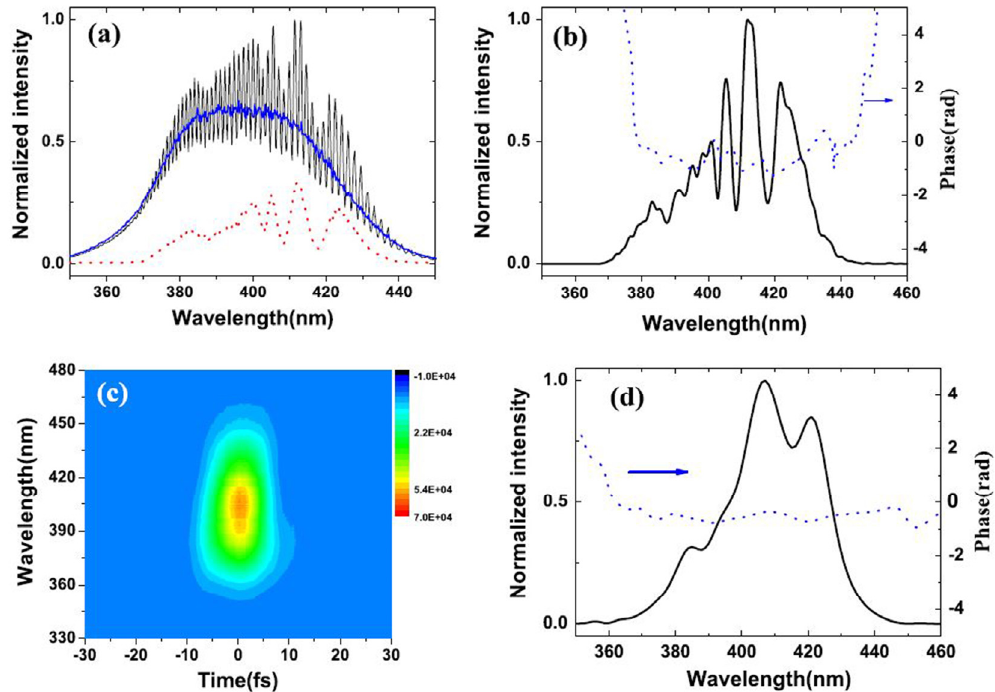
Figure 10. ( a ) Spectra of the compressed pulse at 400 nm (red dotted line), the SD1 signal (blue line), and the interference between them (black line). ( b ) Reconstructed spectrum (black solid line) and spectral phase (blue dotted line) obtained using SD-SRSI. ( c ) Two-dimensional SD-FROG trace of the compressed pulse at 400 nm. ( d ) Reconstructed spectrum (black solid line) and spectral phase (blue dotted line) obtained using SD-FROG [43].